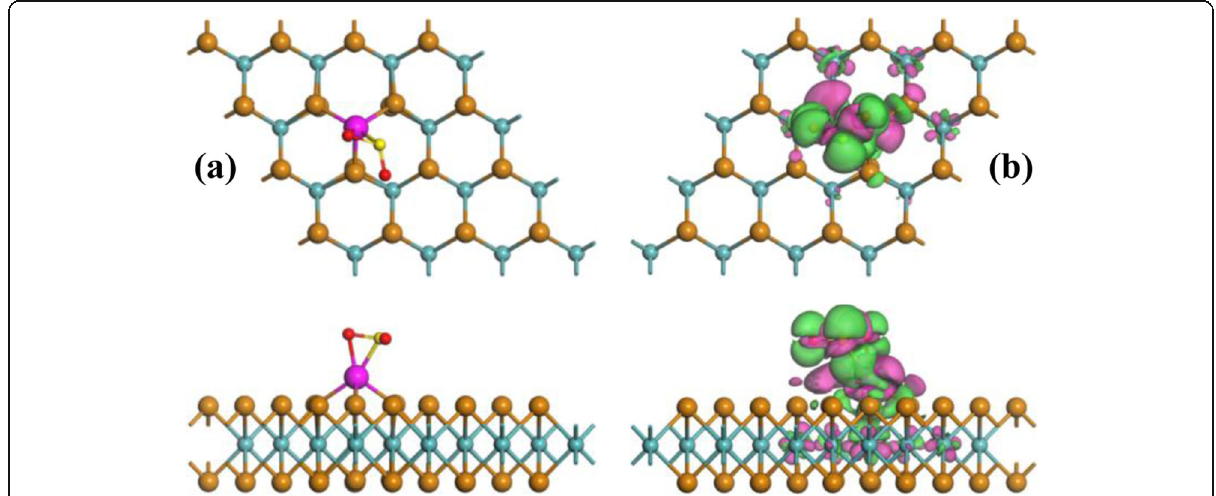
Fig. 3 MSC ( a ) and EDD ( b ) of Rh-MoTe 2 /SO 2 system. In EDD, the green (rosy) areas indicate electron accumulation (depletion), with isosurface as 0.005 e/Å